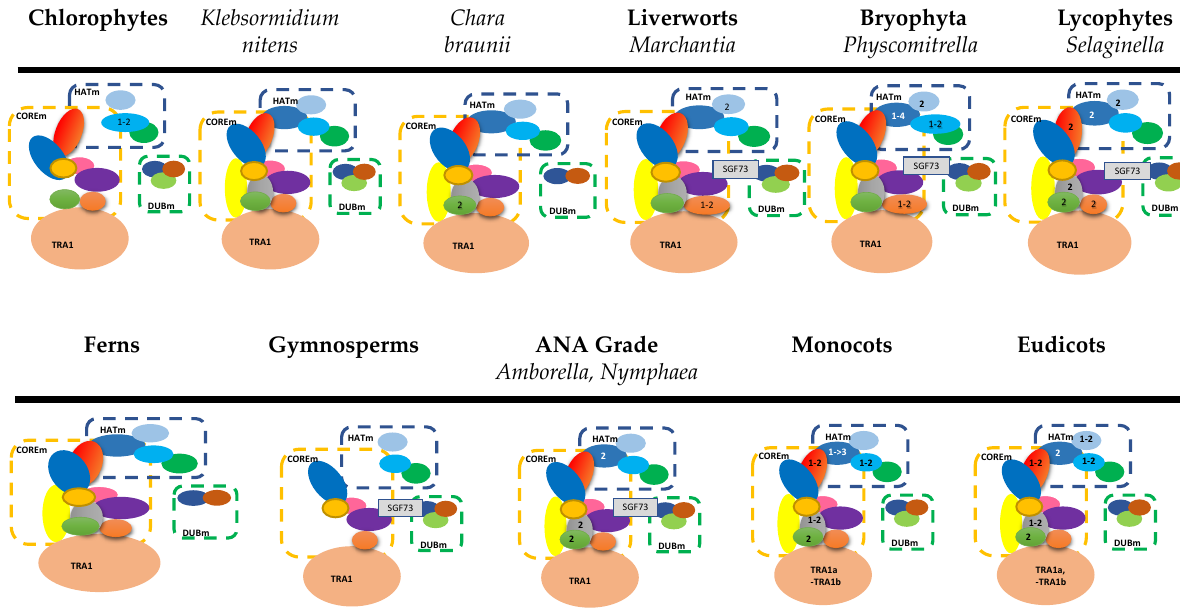
Figure 2. SAGA component proteins in Viridiplantae. HATm is the HAT module, COREm is the CORE module, and DUBm is the DUB module. The numbers indicate duplicated